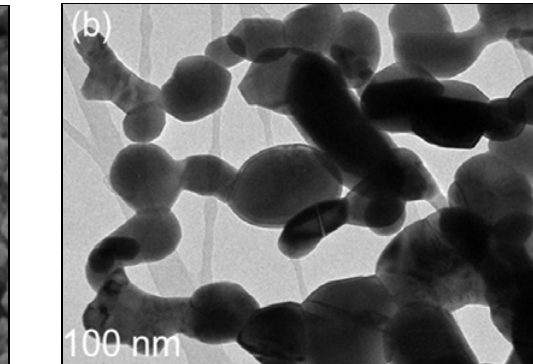
ming carbon-oxygen compounds. 57 The rapid mass loss between 350 °C and 420 °C was caused by the oxidation of carbon. Above 420 °C, almost no more weight